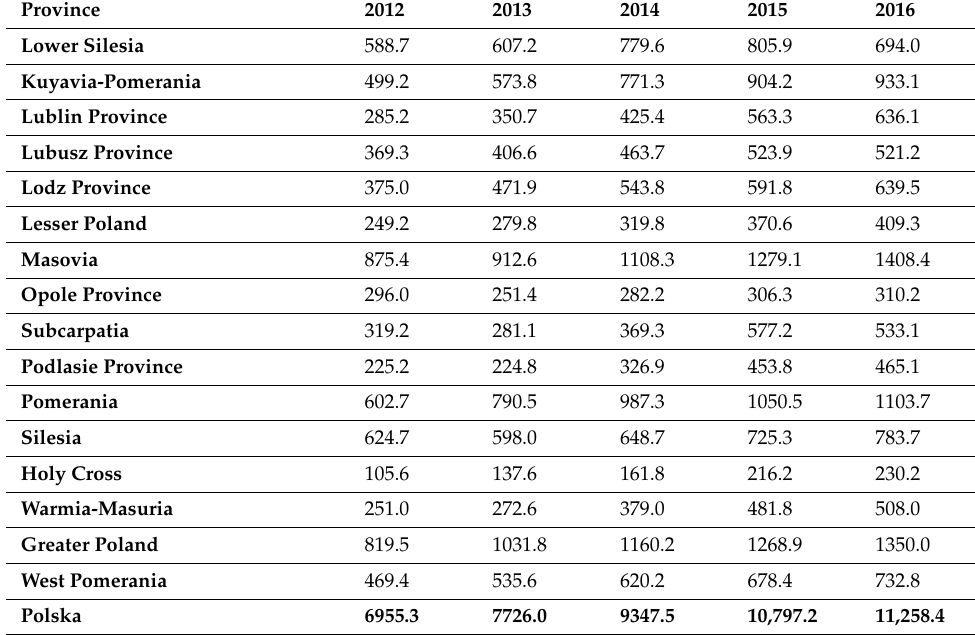
Table 2. Bicycle roads in Poland in